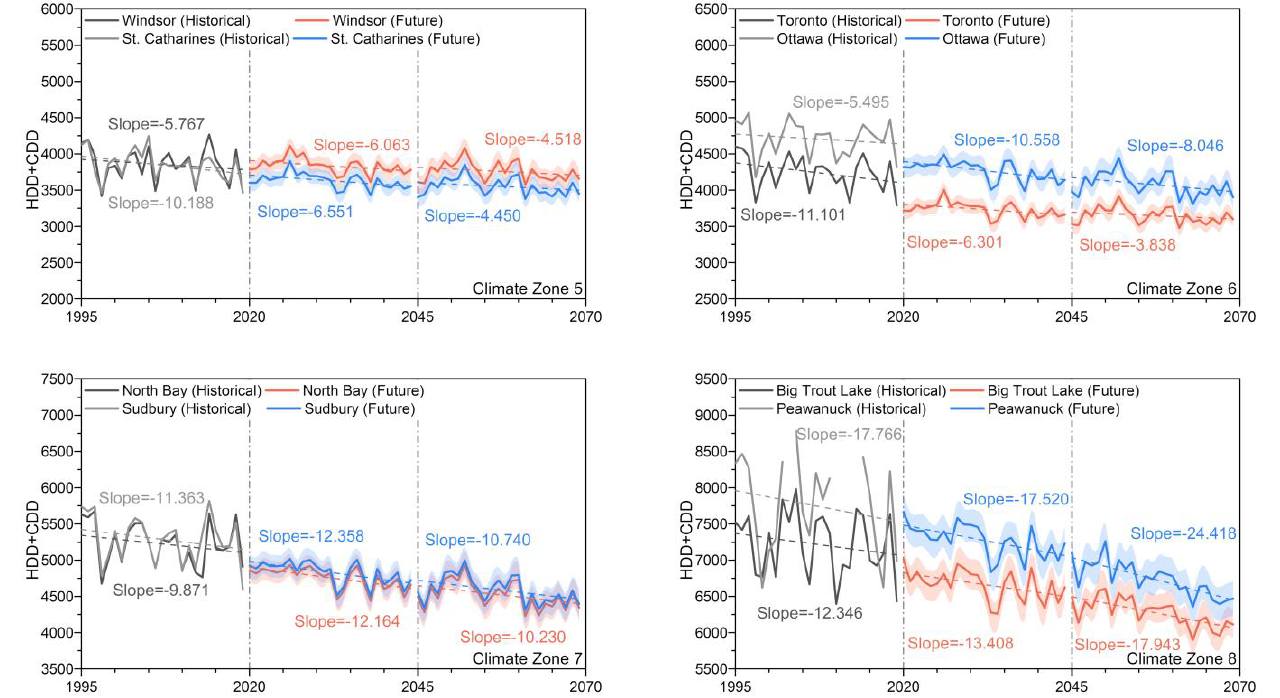
Figure 10. Historical (1995–2019) and future (2020–2069) annual HDD + CDD for climate